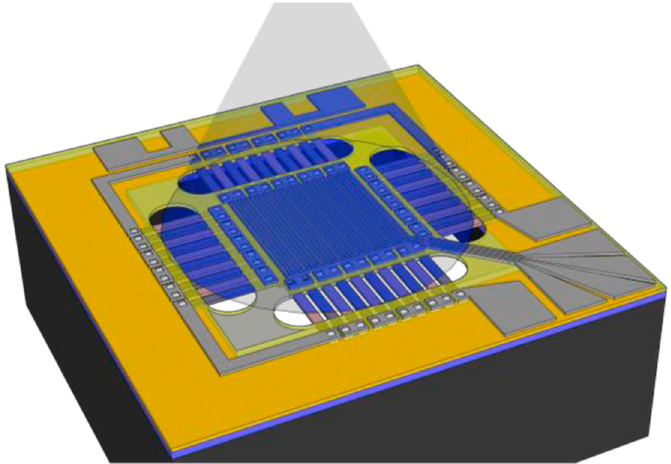
Figure 1. Schematic of the device showing the illuminated